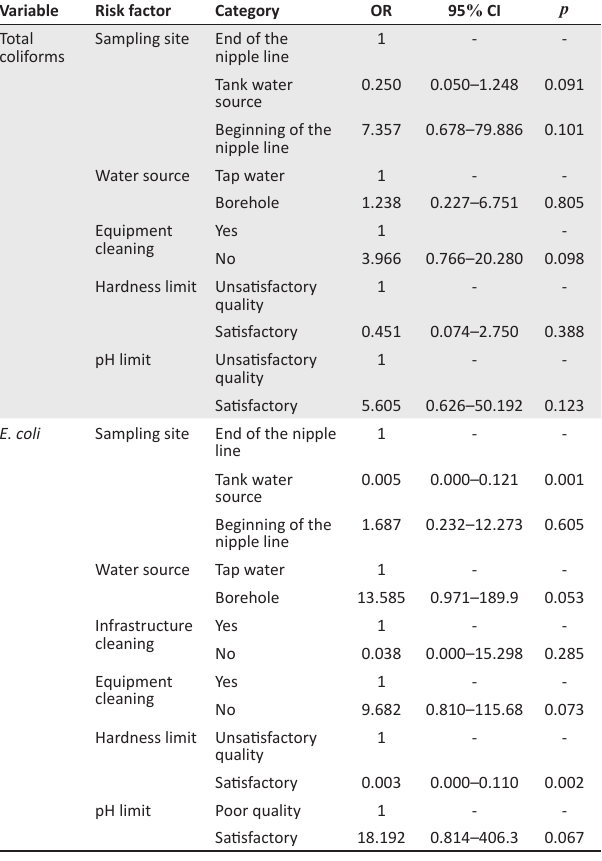
TABLE 3: Binary regression model of risk factors related to water quality for laying hens.